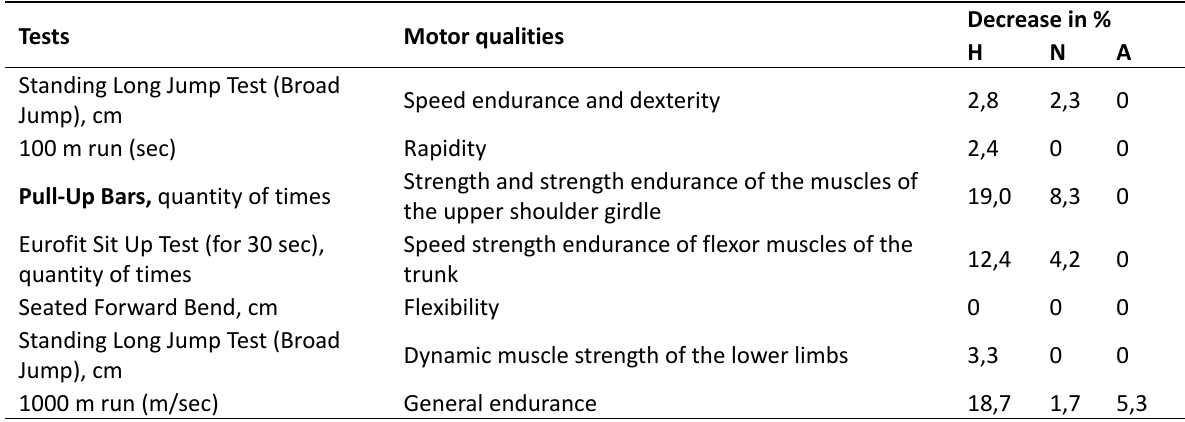
Table 4. The decrease of indicators in motor tests in young men (2017) IN comparison with the results of tests in young men (2008) (in %)